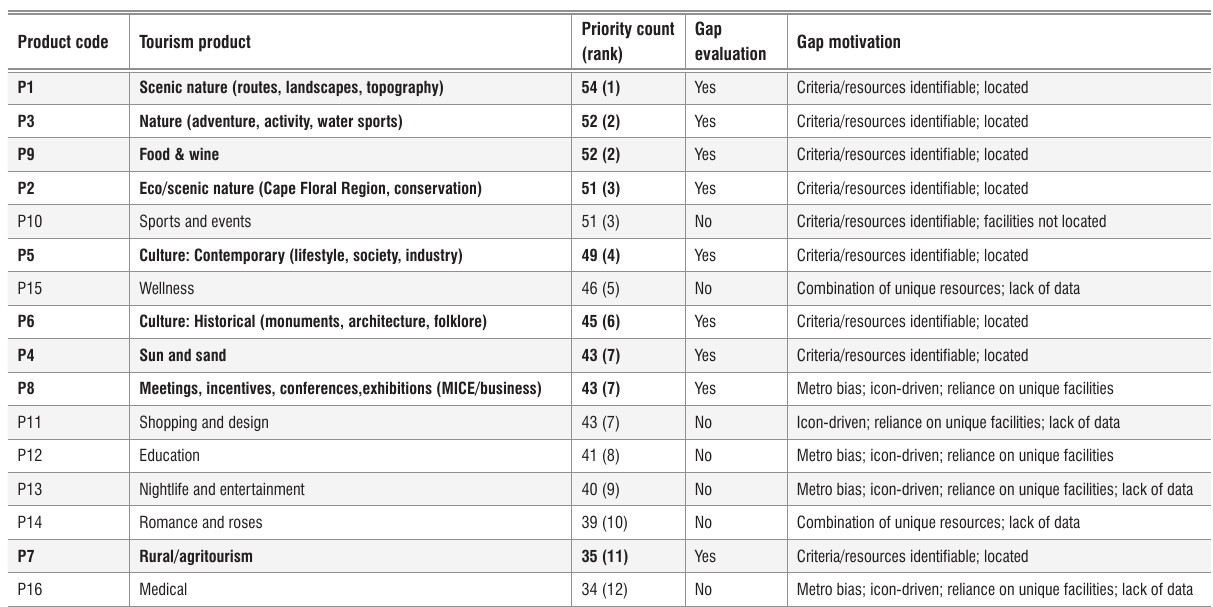
Table 1 : Workshop-derived tourism market segmentation of the Western Cape Province